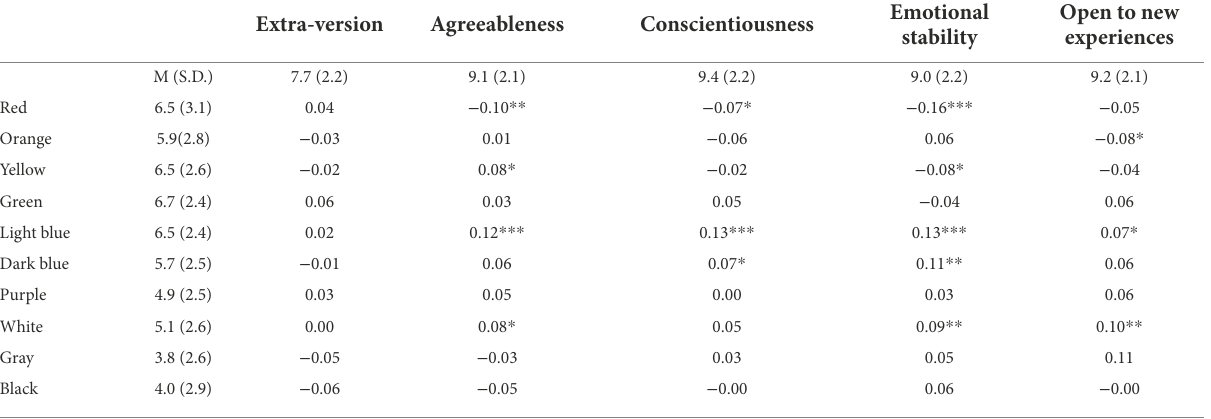
TABLE 2 Correlation coefficients and descriptive statistics for measurement